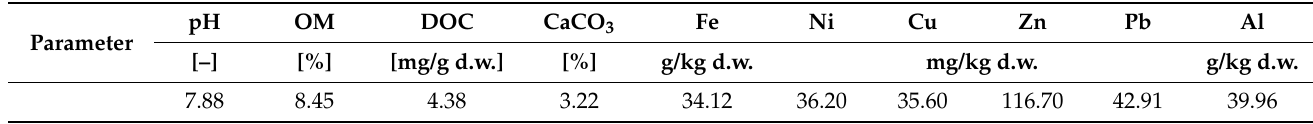
Table 3. Selected physicochemical parameters of the bottom sediments.